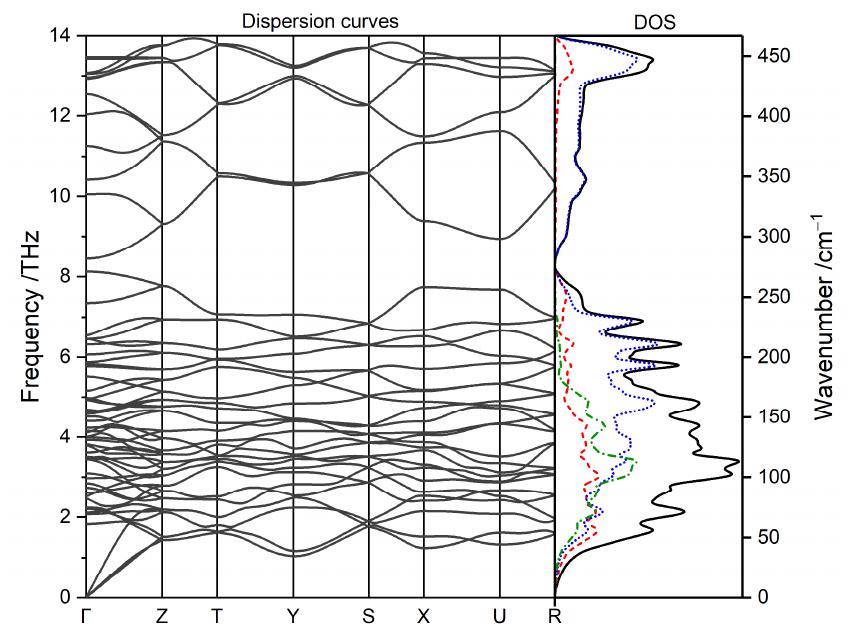
Figure 5. The calculated phonon dispersion and phonon (atomic) density of states for KAgF 3 (blue dotted line—F, red dashed line—Ag, green dash-dotted line—K).